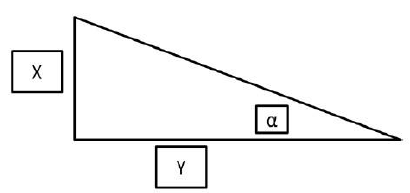
Figure 2 Relationship of Parameters